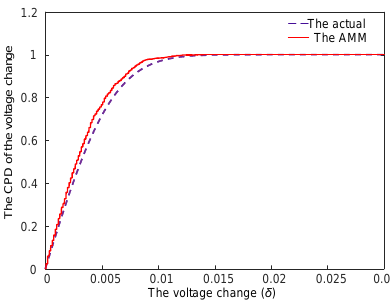
Figure 8. The CPD curve of the voltage change of node 23.